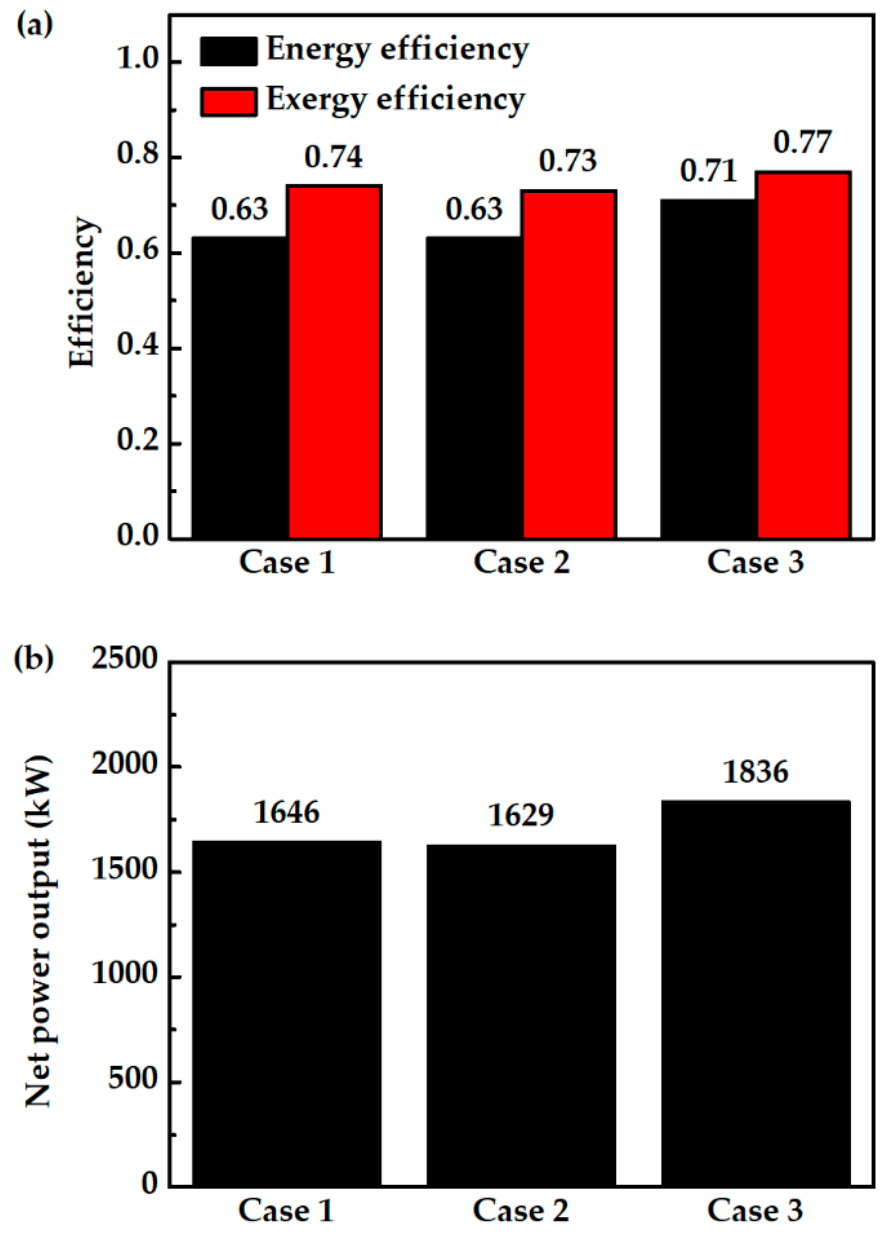
Figure 6. Case comparison results; ( a ) energy and exergy efficiency and ( b ) net power output.